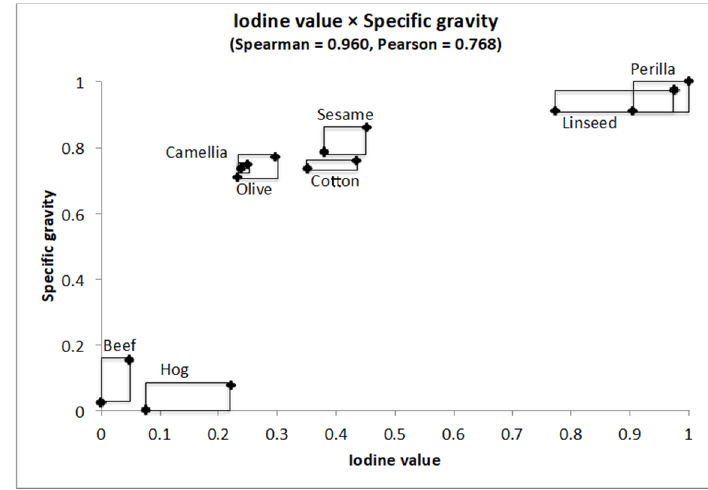
Figure 11. Scatter diagram using two informative features.